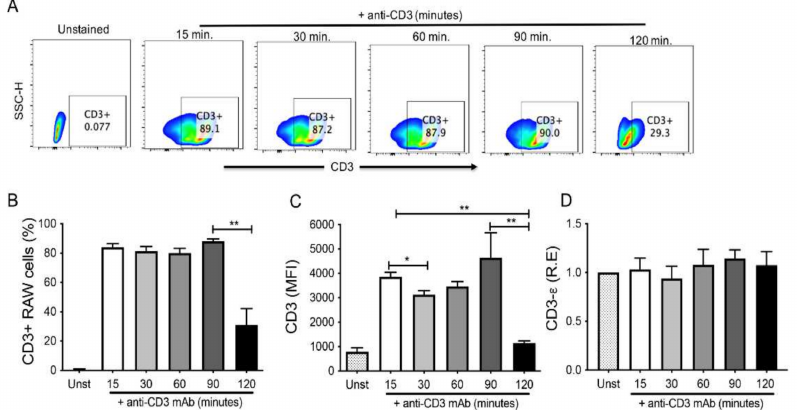
Figure 2. CD3 is endocytosed on RAW macrophages. ( A ) Representative dot plot showing analysis strategy to identify by flow cytometry the extracellular CD3 expression at different times after adding anti-CD3. ( B ) Frequency of CD3+ RAW at different indicated times. ( C ) Mean fluorescence intensity (MFI) of CD3 in RAW cells at indicated time points. ( D ) RNA was obtained from the RAW cells after anti-CD3 addition at different times to assess the relative expression (R.E) of CD3- Σ by qPCR. n = 5 independent experiments (for flow cytometry), n = 3 independent experiments performed by duplicate (for qPCR). Bars represent the mean value ± SD (to ( B , C )) or the mean of means ± SEM (to ( D )). Differences between times were analyzed using the Kruskal–Wallis and corrected for the Dunn test for flow cytometry data and one-way ANOVA followed by the Bonferroni test for qPCR. * p < 0.05, ** p <